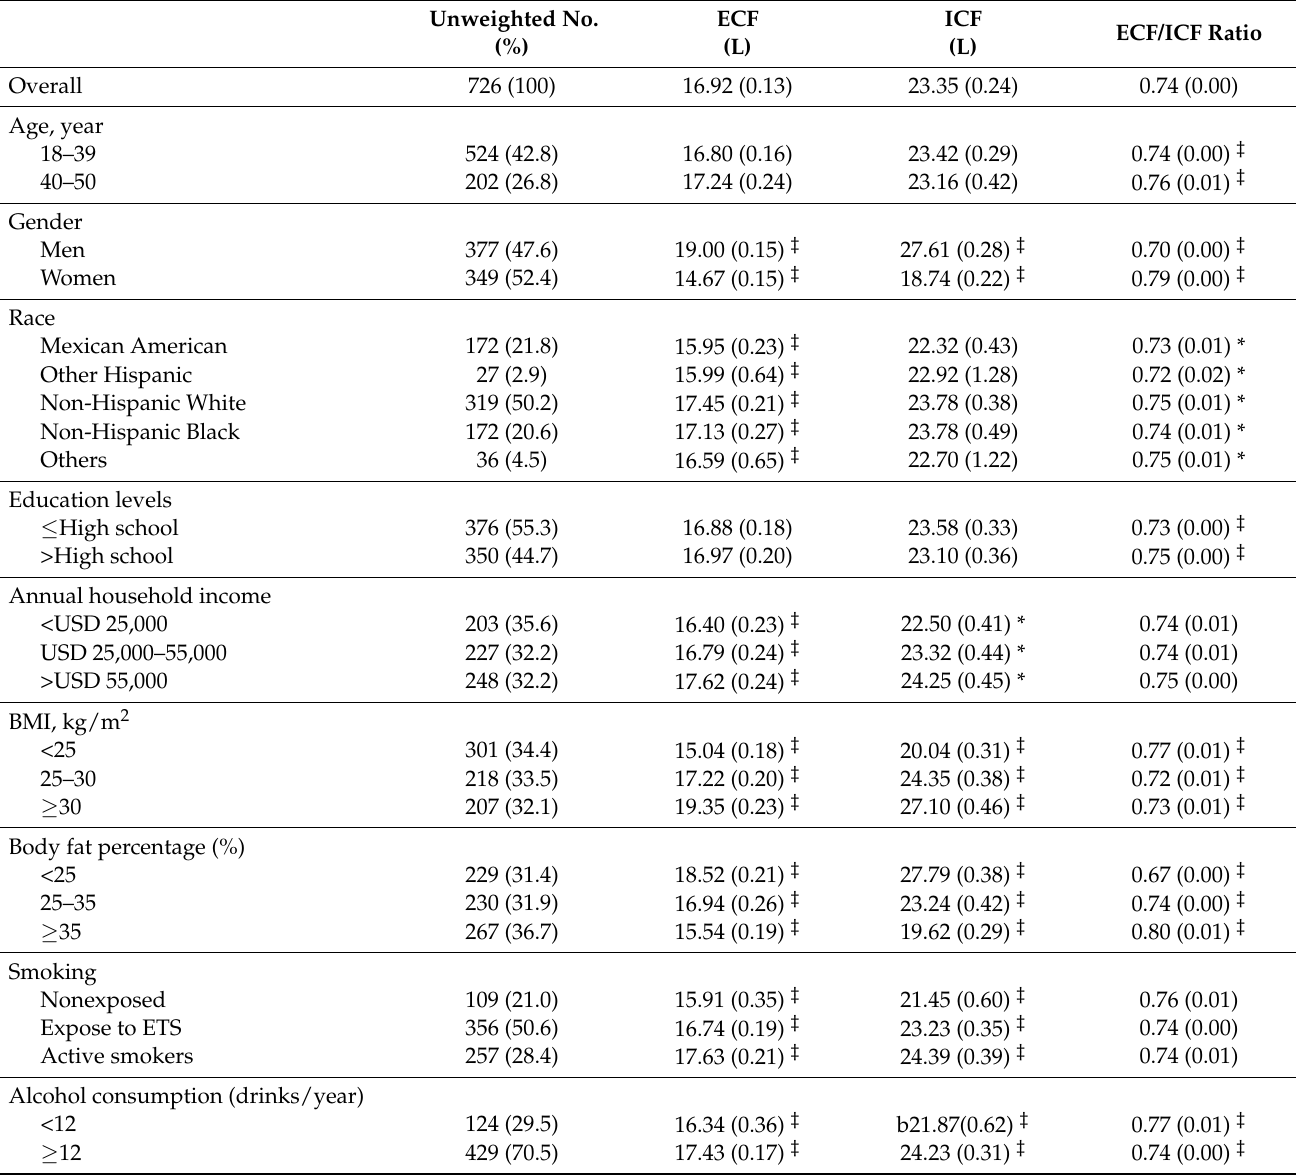
higher ECF and ICF volumes. A higher ECF volume was also found in subjects who were non-Hispanic white. Subjects aged between 40 and 59 years old, female gender, higher education level, lower BMI, higher body fat percentage, and lower alcohol consumption were associated with a higher ECF/ICF ratio, while a lower ECF/ICF ratio was found in other Hispanics. Table 2. Basic demographics of the sample subjects, including means (S.E.) of body fluid status. Unweighted No. ECF (%)